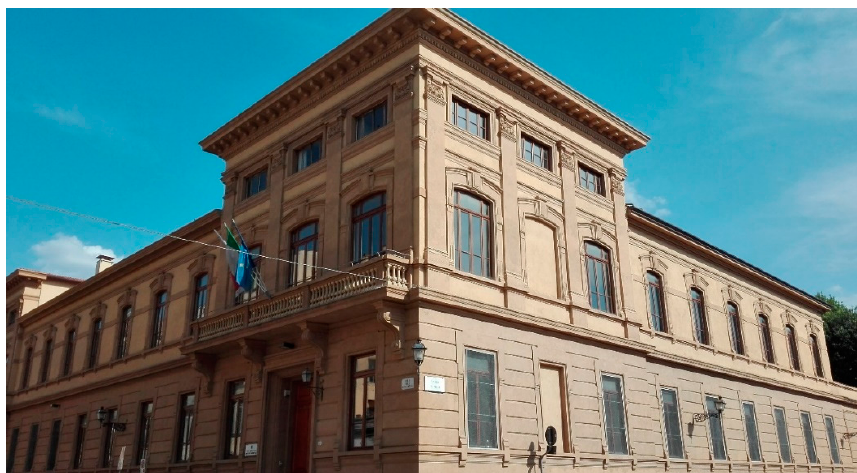
Figure 5. The secondary school “Machiavelli” in the Municipality of Florence.